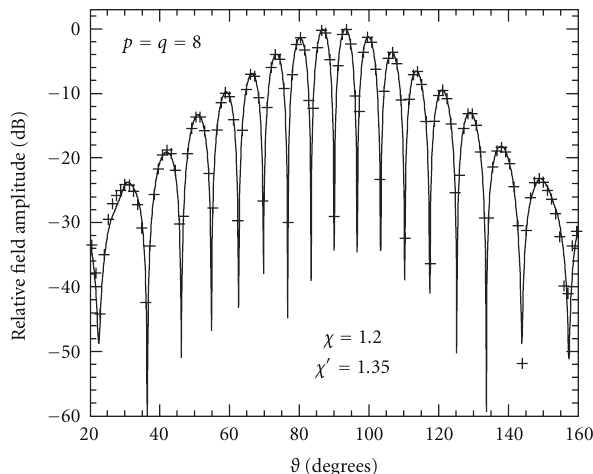
Figure 14: H-plane pattern. Solid line: direct FF measurements. Crosses: reconstructed from NF data acquired via the nonredun- dant cylindrical